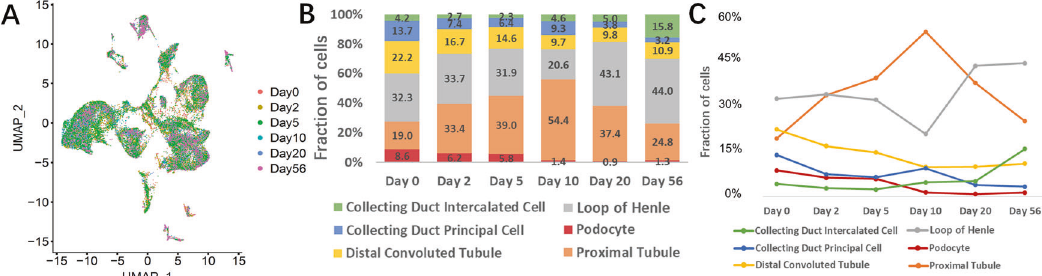
Fig. 2 Dynamic changes in major kidney cell types over time. A UMAP plots of six different developmental stages of rat kidney after birth. B The six major kidney cell types, namely, collecting duct intercalated cell, collecting duct principal cell, distal convoluted tubule, loop of Henle, podocyte, and proximal tubule were normalized to 100% at the same time point. The proportions of each cell type at each point are stacked, and dynamic changes are presented over development time. C The change trends of the proportion of each major kidney cell type during different developmental stages are indicated with broken lines. Podocyte, collecting duct principal cells, and distal convoluted tubules showed decreases during the postnatal period while collecting duct principal cells show an increase over time. Loop of Henle showed a decrease from postnatal days 0 to 10 and then an increase, while proximal tubules present the opposite